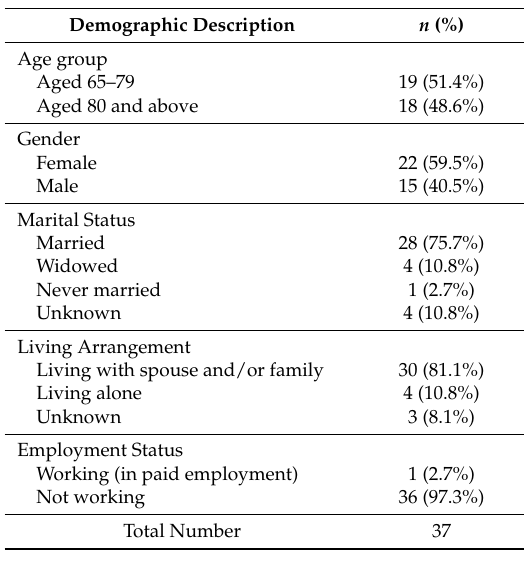
Table 1. Demographic description of focus group participants by age group, gender, marital status, living arrangement, and employment